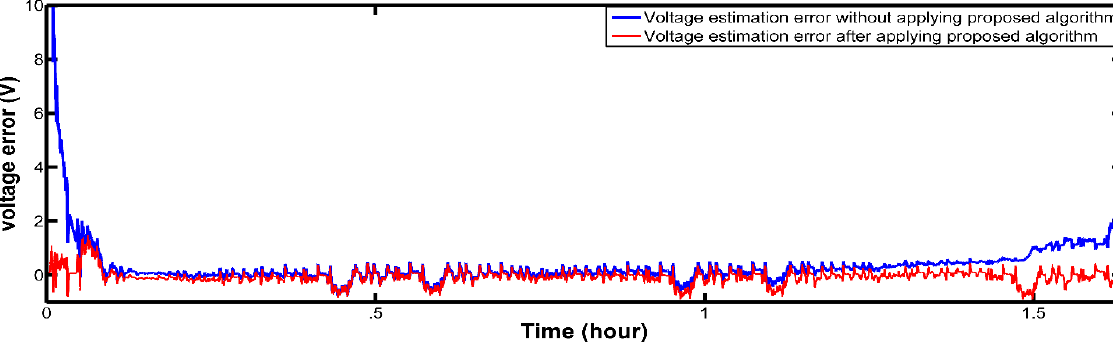
Figure 13. Estimated voltage error of the battery pack for about 2 hours before and after applying proposed method discharging with FTP-75 current profile from initial 89%